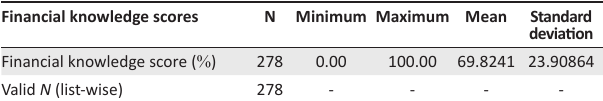
TABLE 8: Total variance explained for financial knowledge.